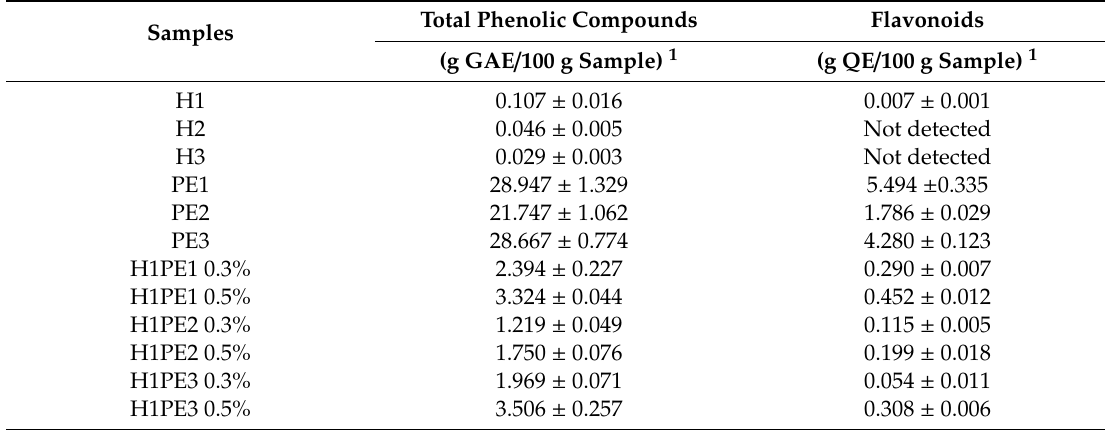
Table 1. Total phenolic compounds and flavonoids content of the